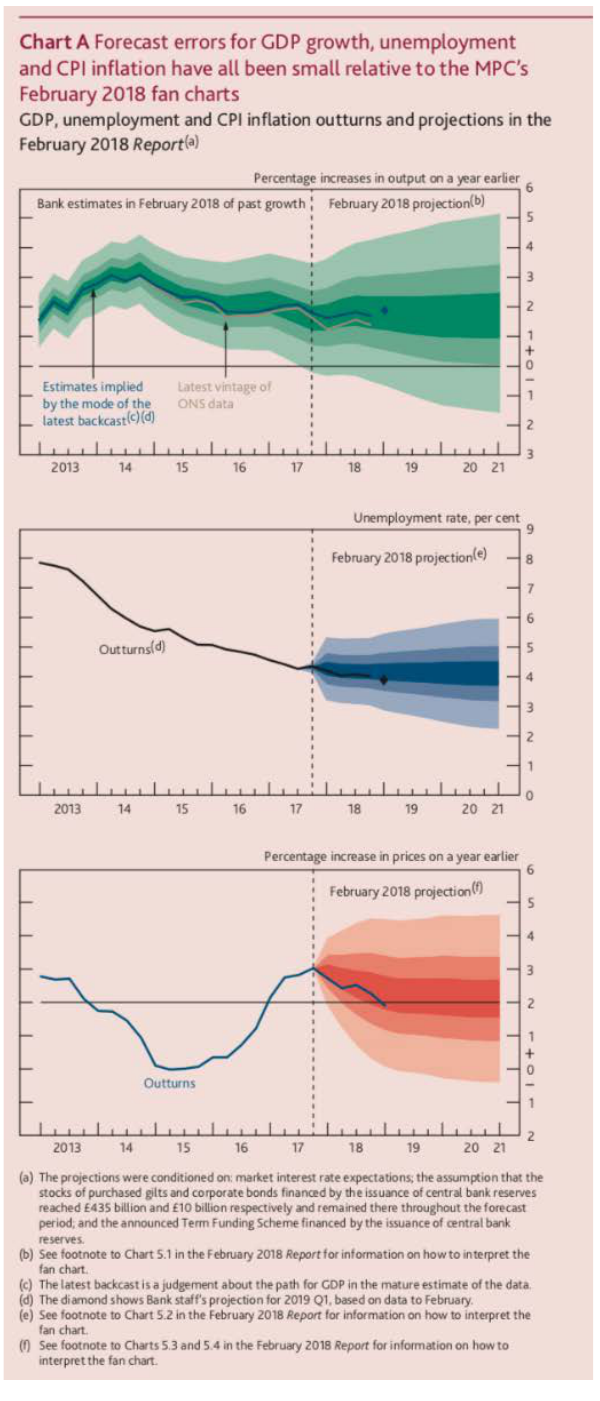
Figure 3 : The latest Bank of England fan chart for GDP growth (above), unemployment rate (middle) and inflation (below). From Bank of England, Inflation Report May